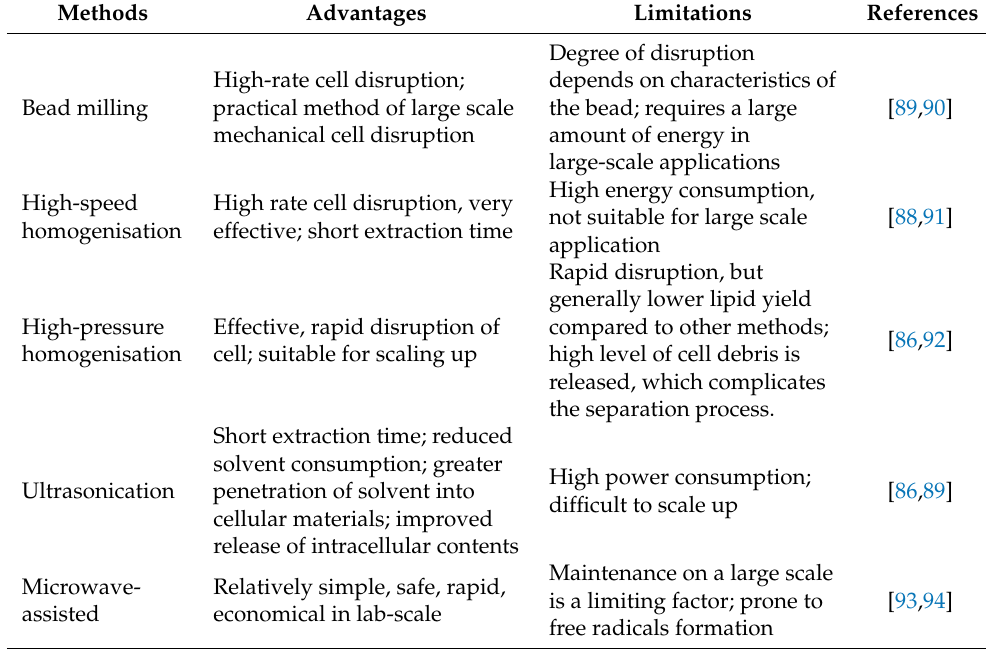
Table 4. Summary of various lipid extraction methods.